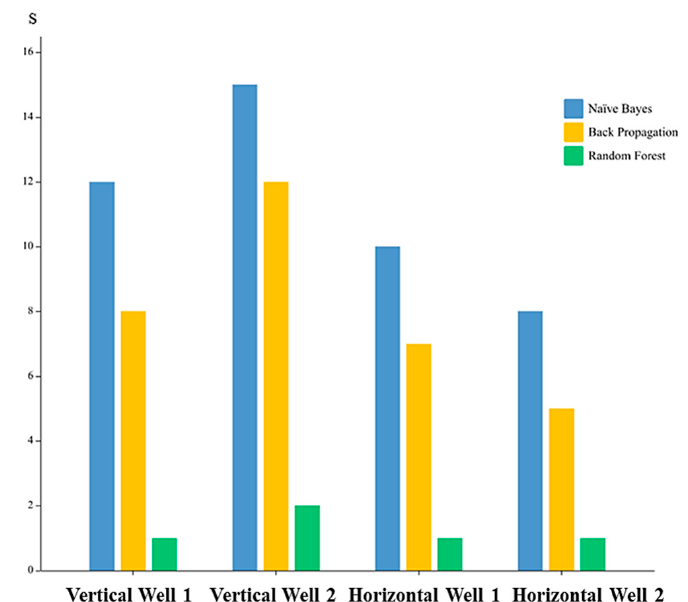
Figure 13. Comparison of the running time of the three algorithms. Whether vertical or horizontal wells, the running time of random forest is shorter than that of back propagation, and the naive Bayesian algorithm takes the longest running time.